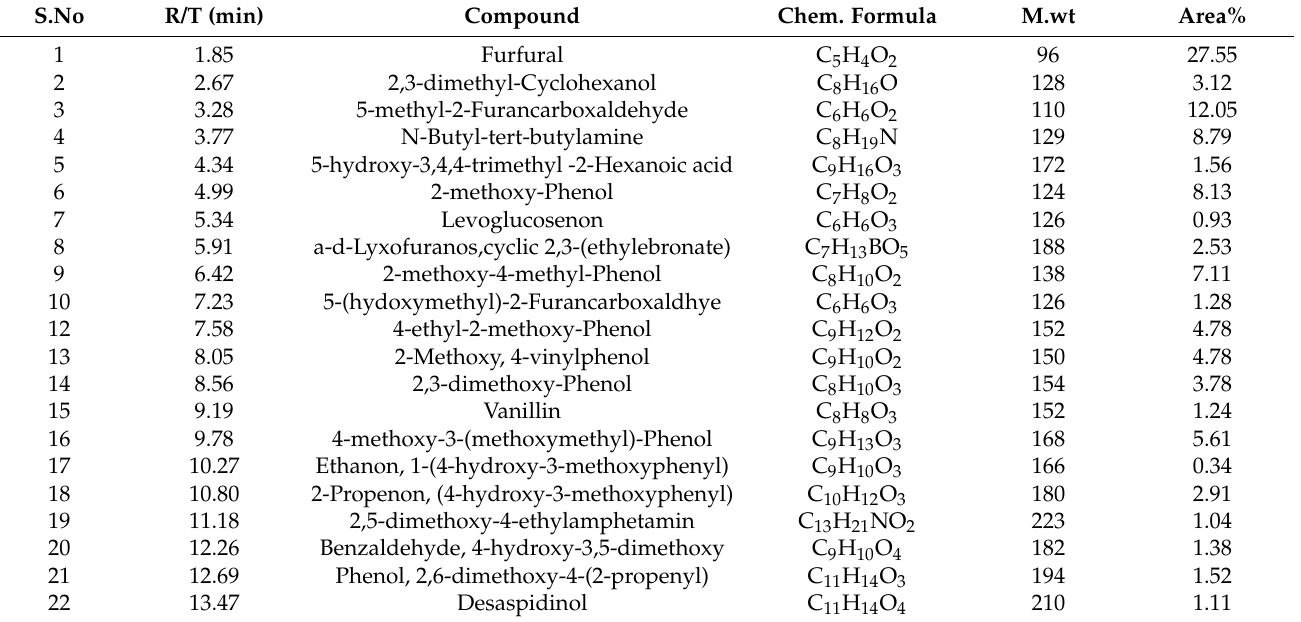
Table 1. Components identified in bio-oil produced from non-catalytic pyrolysis of pomegranate